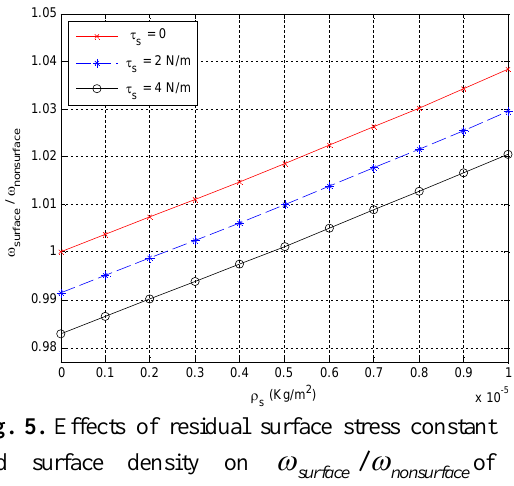
Fig. 5. Effects of residual surface stress constant   of and surface density on / surface nonsurface piezoelectric nanocomposite plate for CPT Fig. 6 illustrates the influences of inclusion volume to total volume ratio (  ) and SWCNT volume fraction in the inclusion (  ) ratios on /   of piezoelectric composite nonlocal local plate for CPT and FSDT. It is concluded that /   decreases with increasing of nonlocal local  and vice versa for  . As  increases, the SWCNT accumulation in PVDF increases   decreases. hence / nonlocal local In Fig. 7, effects of the nonlocal parameter and   of aspect ratio ( / a b ) on / nonlocal local Fig. 4. Effects of residual surface stress constant piezoelectric nanocomposite plate for CPT and   of and surface Lame constant on / surface nonsurface FSDT using the E-M-R are demonstrated. As it piezoelectric nanocomposite plate a- CPT b- FSDT   can be seen that deference of / nonlocal local Effects of residual surface stress constant and in higher nonlocal parameter for FSDT is  ) on /   of surface density ( higher than that of for s surface nonsurface piezoelectric nanocomposite plate for CPT are shown in Fig. 5. It is clear that /   increases with increasing surface nonsurface  . of s